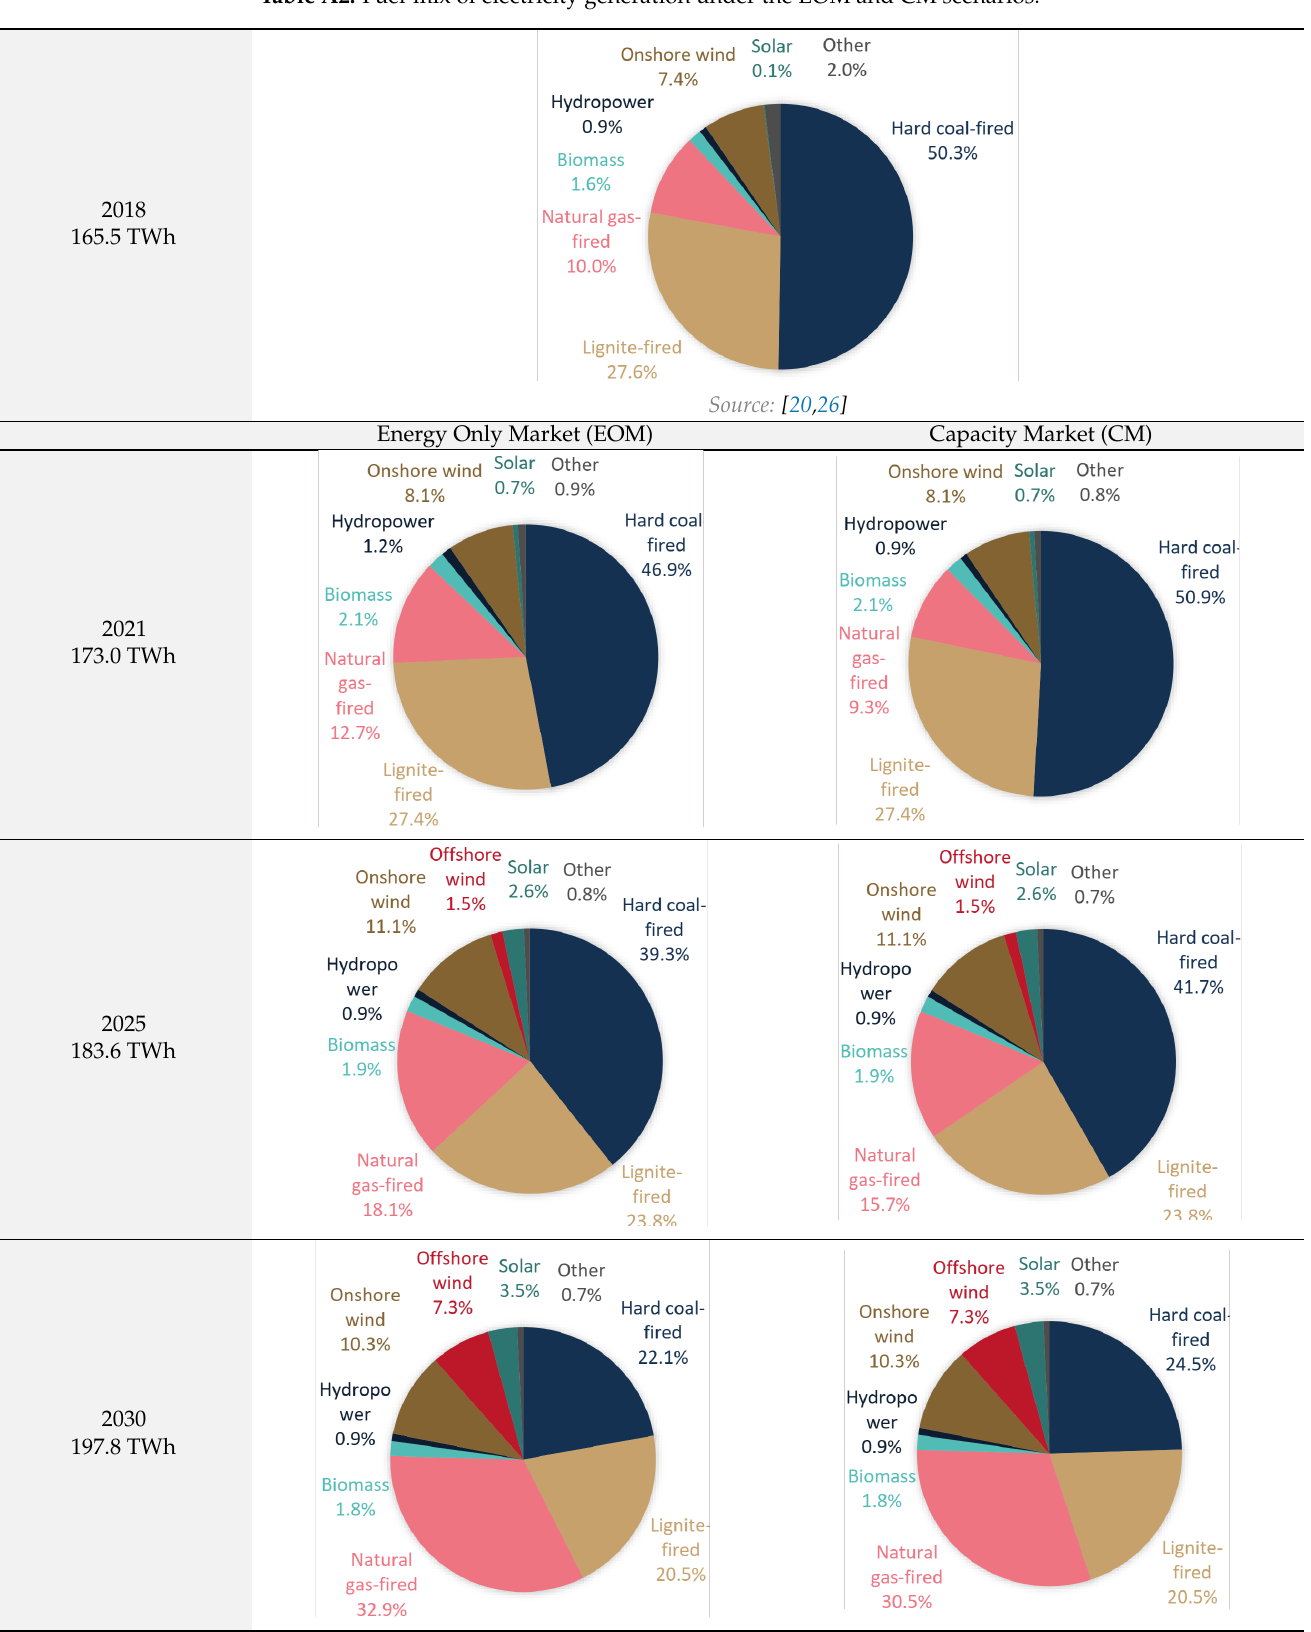
Table A2. Fuel-mix of electricity generation under the EOM and CM